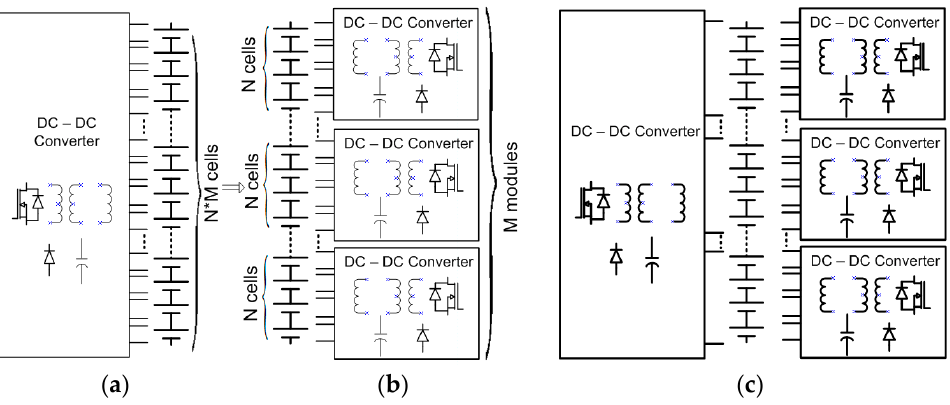
Figure 7. Modular circuit balancing concept: ( a ) Conventional cell balancer; ( b ) Modular cell balancer; ( c ) The modular cell balancer based on outer-module.